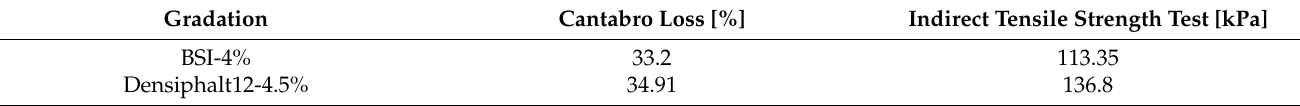
Table 3. Effects of gradations on physical properties of OAC